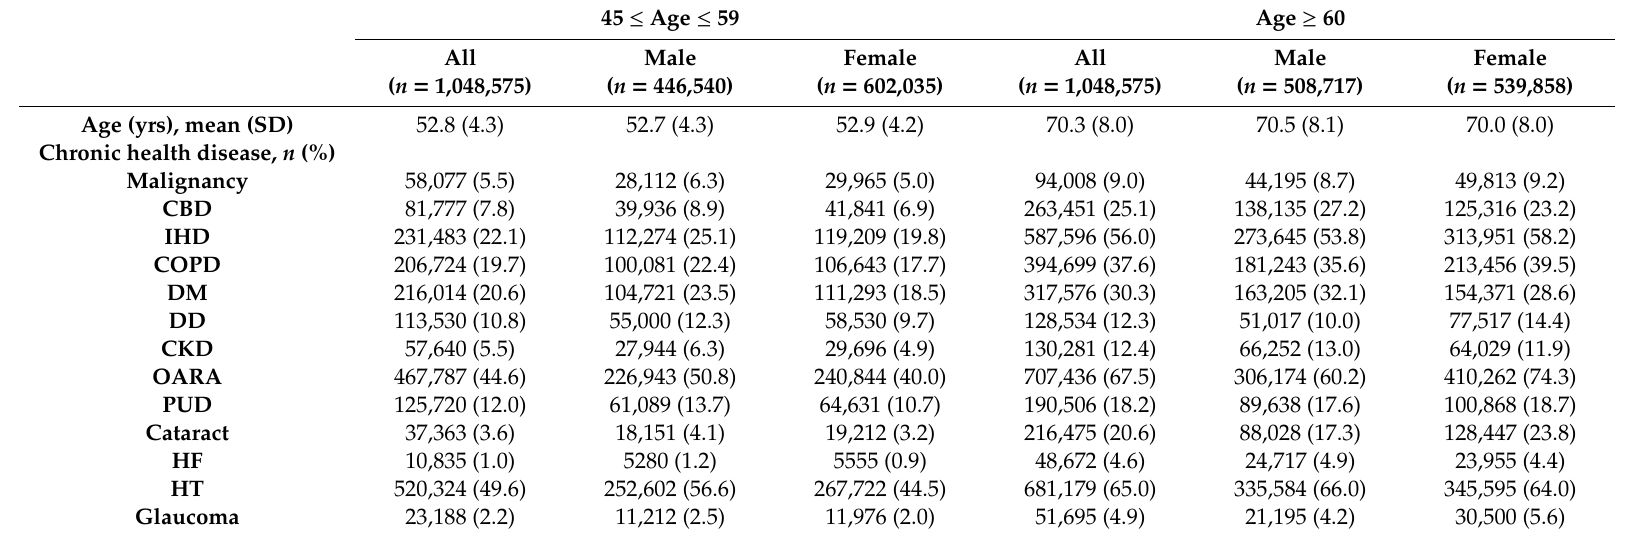
Table 1. Observed prevalence of chronic diseases by age and